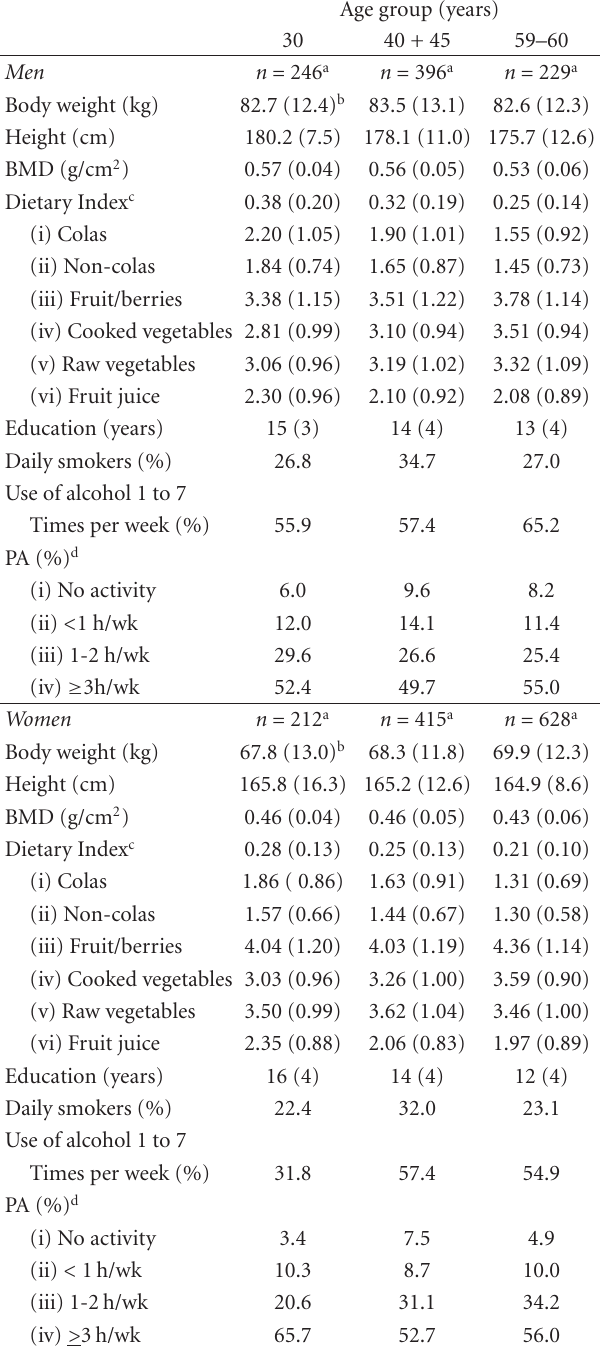
Table 1: Characteristics of the study sample ( n =